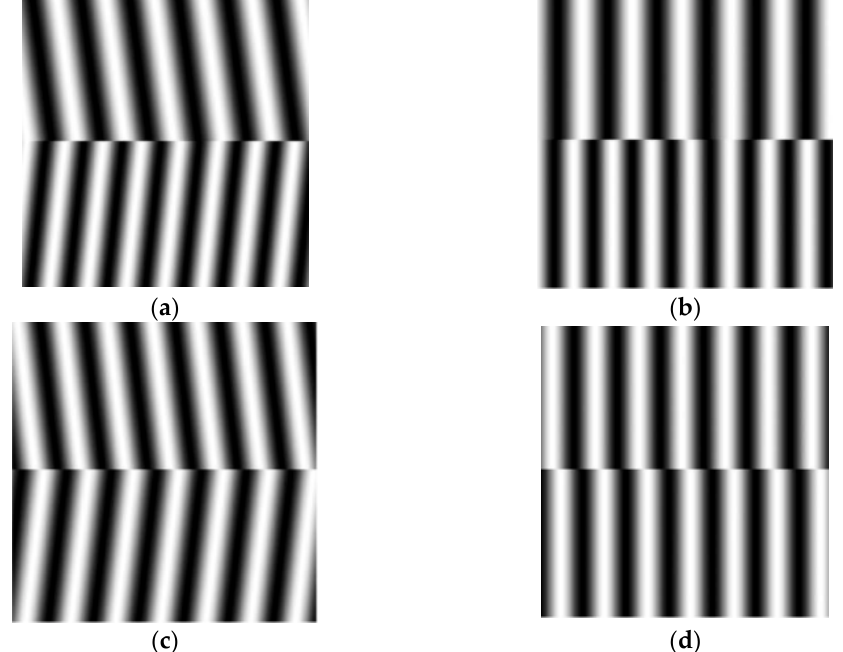
Figure 4. Distribution of two sets of fringes when the wafer is tilted. ( a ) Both sections. ( b ) Only the cross-section. ( c) Only the longitudinal section. ( d ) Leveled.